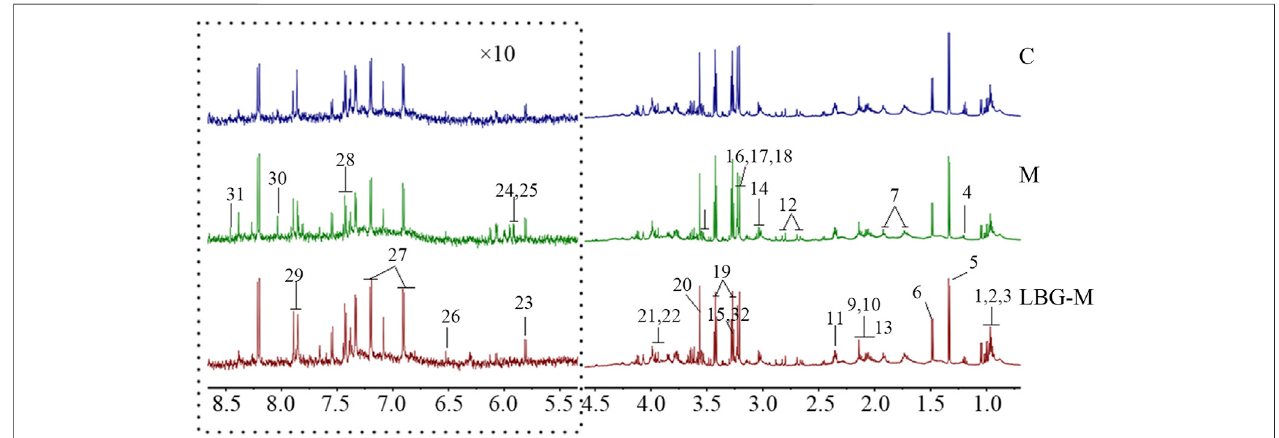
FIGURE 2 | The 1 H-NMR spectra of mice spleen tissue in C, M and LBG-M groups.